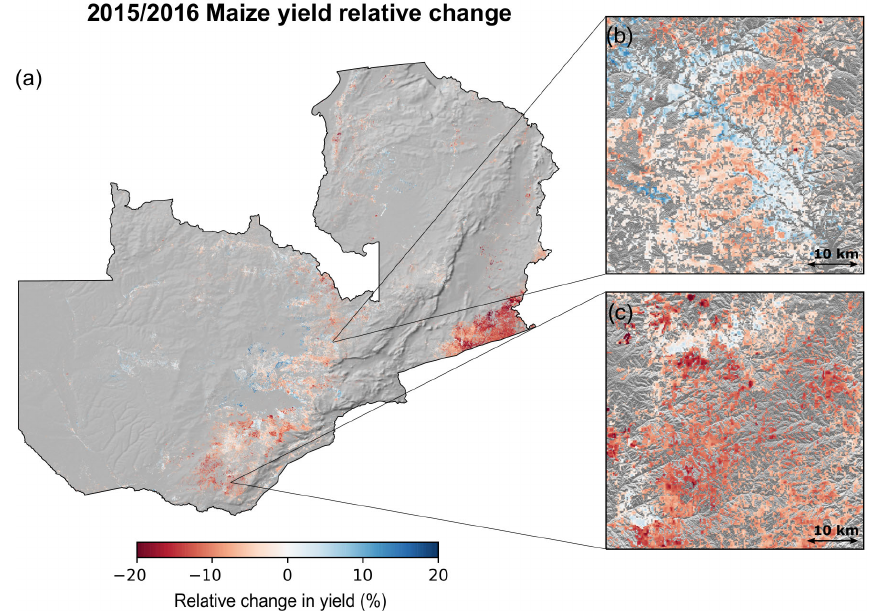
Figure 5. (a) Relative change in maize yields (in percent) for the 2015–2016 season with respect to 2010–2014 mean. Each magnified panel (b, c) shows the respective data at a 250m resolution for a 50km by 50km